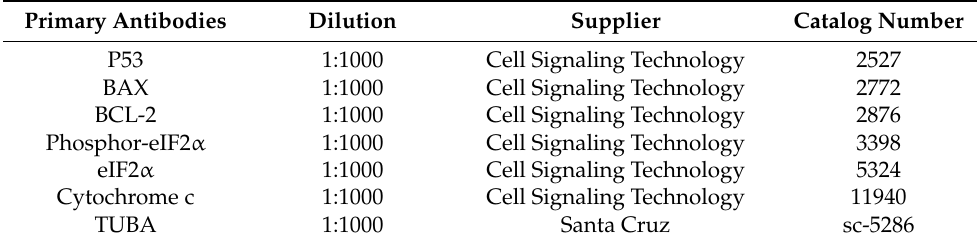
Table 1. List of primary antibodies used in Western blot